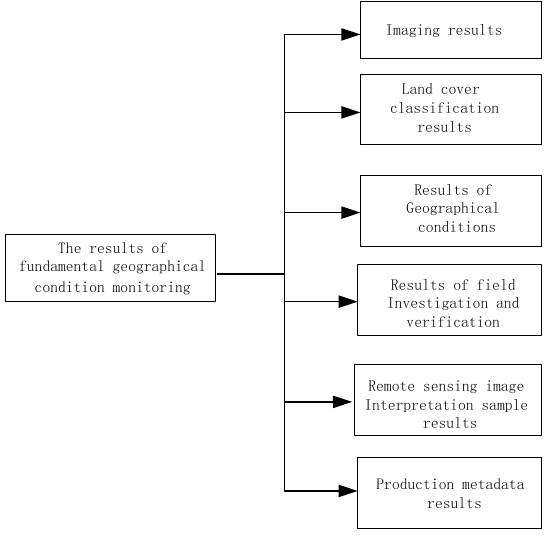
Figure 3. The fundamental geographic and national conditions monitoring data